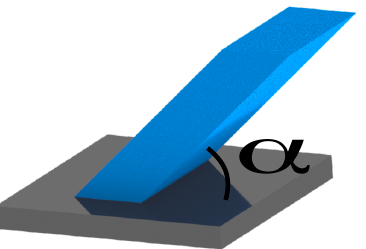
Figure 7. Test specimen for the study of inclined structures without support structures.